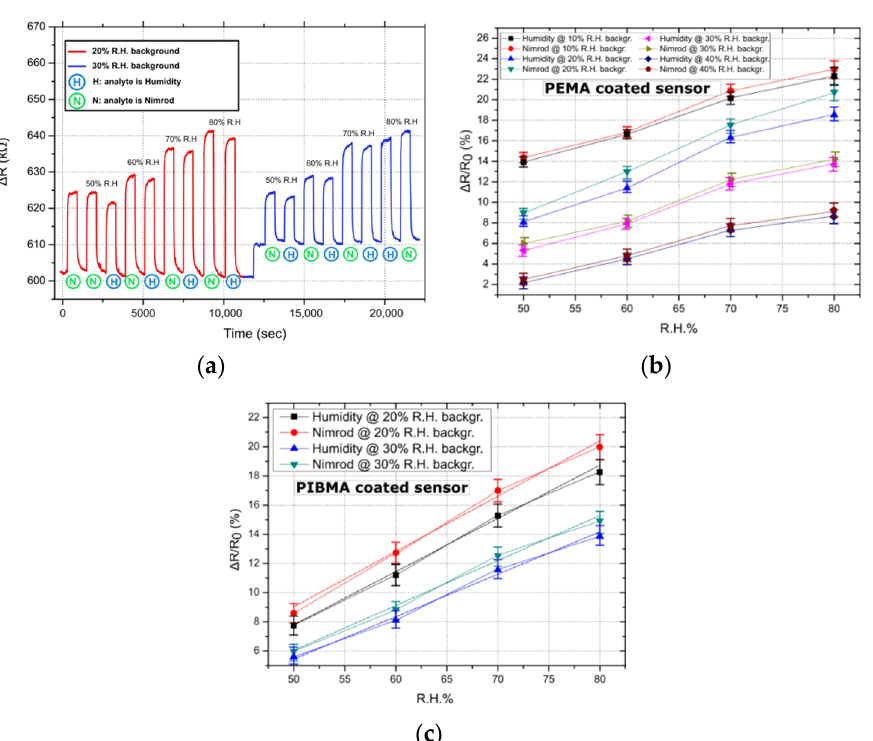
Figure 2. Typical sensor responses for PEMA and PIBMA coated sensors. Linear fitting was per- formed in the case of the best performing sensor (i.e., PIBMA sensors), to showcase the linearity of the sensors’ response. ( a ) Transient sensor response ( Δ R) for the entire range of measured concen- trations: 50–80% of R.H., for a single PEMA sensor. Nimrod measurements correspond to flow rates (measured in ml/min) identical to those used to achieve R.H. values from 50% to 80%. Results are typical of the response of all four polymer coatings, namely PEMA, PHEMA, PIBMA, and PBMA. ( b ) Relative resistance response (measured as Δ R/R0) for PEMA coated sensors and in four different R.H. backgrounds (backgr.). Data points correspond to the mean response of five sensors, while standard deviations are presented as error bars (from 0.56% to 0.87%). ( c ) Typical relative resistance response for PIBMA sensors, focusing on 2 R.H. backgrounds (20% and 30%). Data points corre- spond to the mean response of five sensors, while standard deviations are presented as error bars (0.61% to 0.94%). Linear fitting was performed and is presented as dashed lines. The adjusted R- square value for the linear fit regression was found to be between 0.98926 and 0.99559.